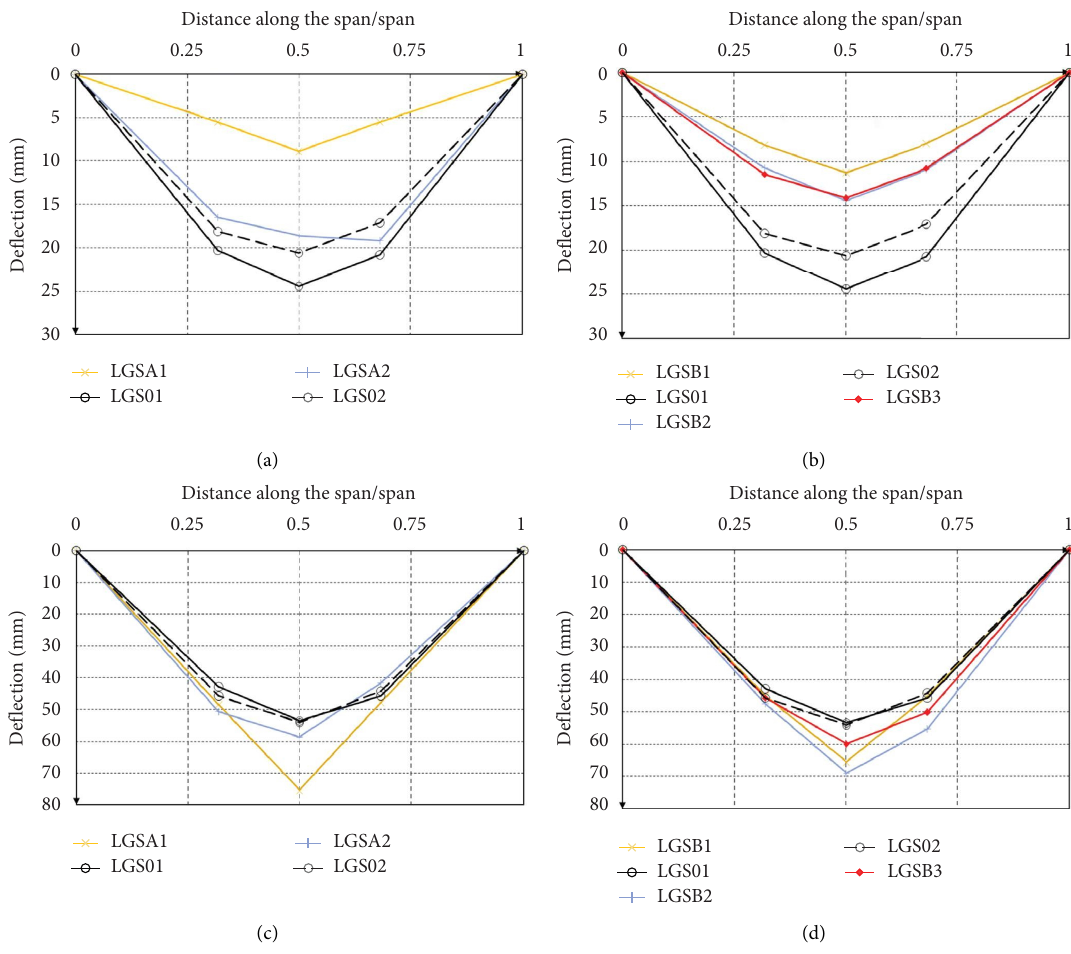
Figure 14: Defected shape of specimens with comparison of control specimens. (a) Specimens in Group A at yield load. (b) Specimens in Group B at yield load. (c) Specimens in Group A at peak load. (d) Specimens in Group B at peak Table 2: Defection ratio of specimens. Spec.